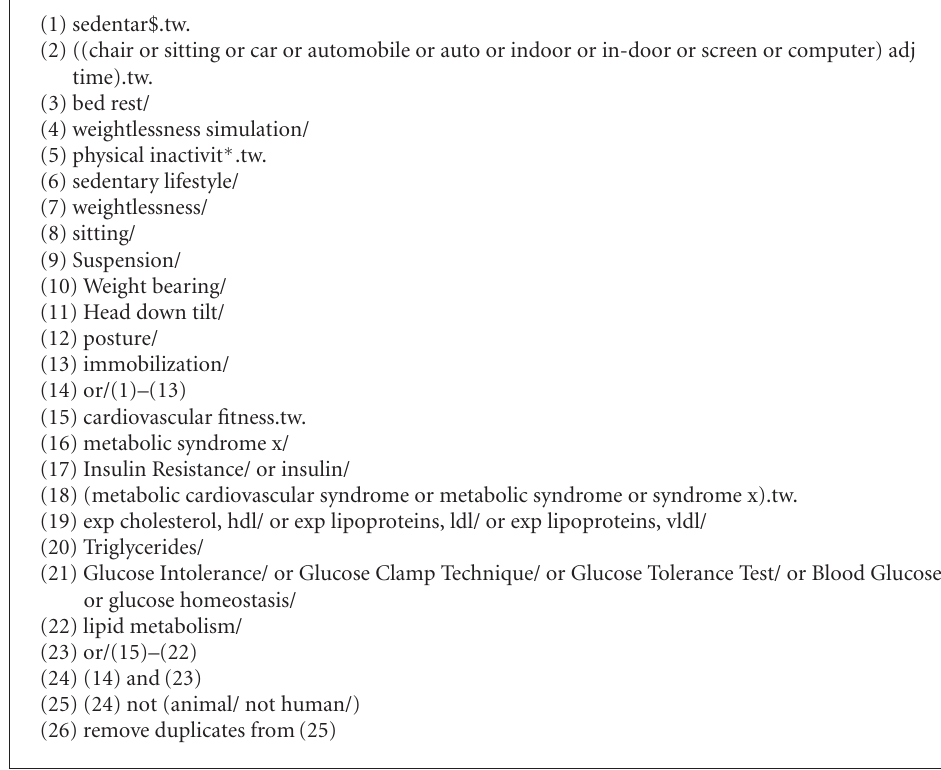
Algorithm 1: Medline search